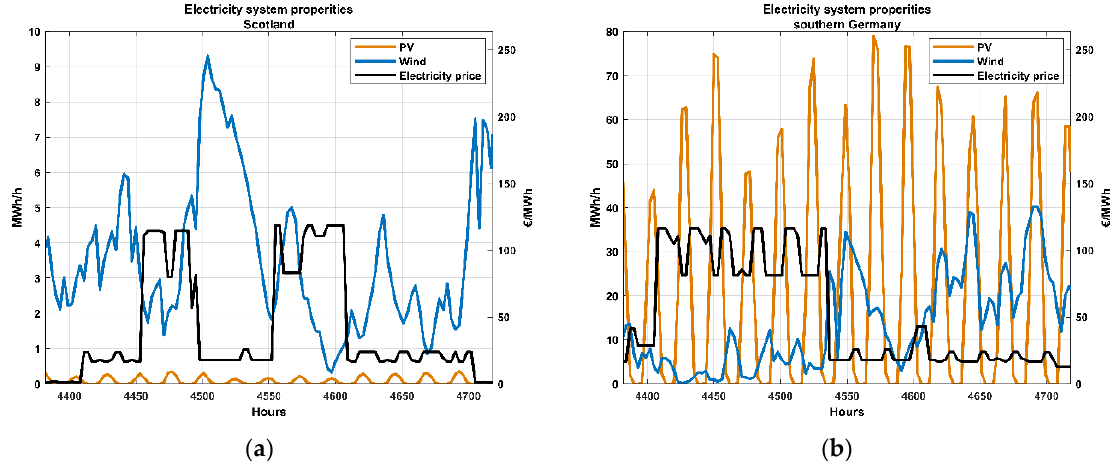
Figure 4. Electricity price curves, together with the levels of wind and solar power generation for: ( a ) Scotland; ( b ) southern Germany, for three weeks in July 2050.